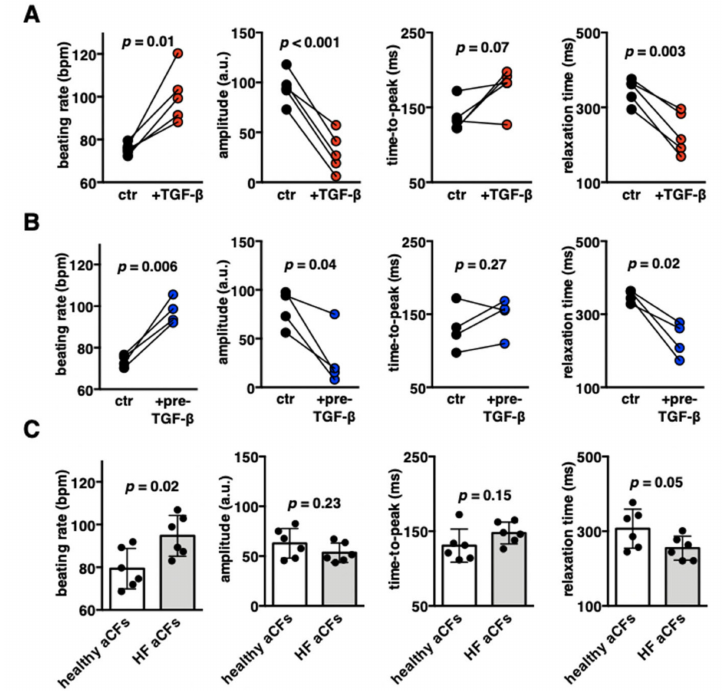
Figure 5. Contractile properties of cardiac microtissues containing foetal or adult cardiac fibroblasts. Panel (A) shows quantification of contraction parameters of iCMs:fCFs microtissues cultured in the presence (red) or absence (black) of TGF- β 1 (10 ng / mL) at day 10. Quantification of contraction parameters of microtissues containing fCFs pretreated with TGF- β 1 for 3 days prior microtissue formation (blue) or untreated fCFs (black) recorded at day 10 are shown in panel (B). Each dot represents average data of one experiment. Data of individual experiments are available in the Supplementary Materials (Figures S5 and S8). p values were calculated with the paired Student’s t -test. Panel (C) shows quantification of contraction parameters of cardiac microtissues containing aCFs from una ff ected hearts (white) or heart failure (HF) patients (grey). Each dot represents average data of one experiment ( n = 14–18). p values were calculated with the Student’s t -test. Representative contraction records